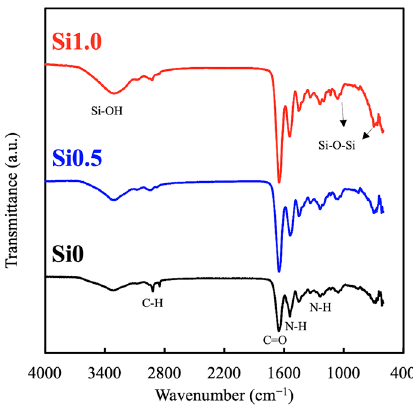
Figure 1. FTIR spectra of the various Si-GelMa (gelatin methacrylate)